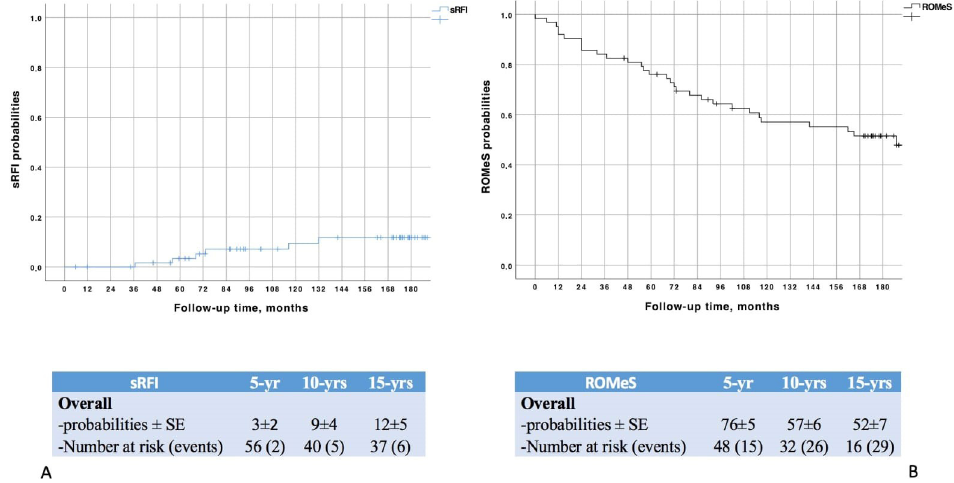
Figure 1. Probabilities of developing a significant renal function impairment ( A )